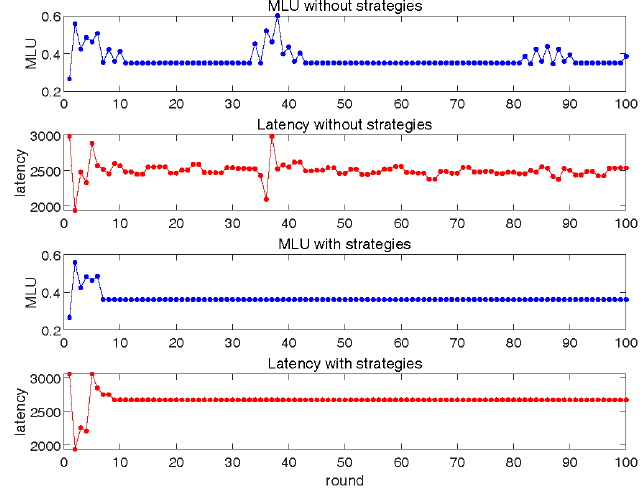
Figure 12. Interaction between fully functional SRC and LLS.